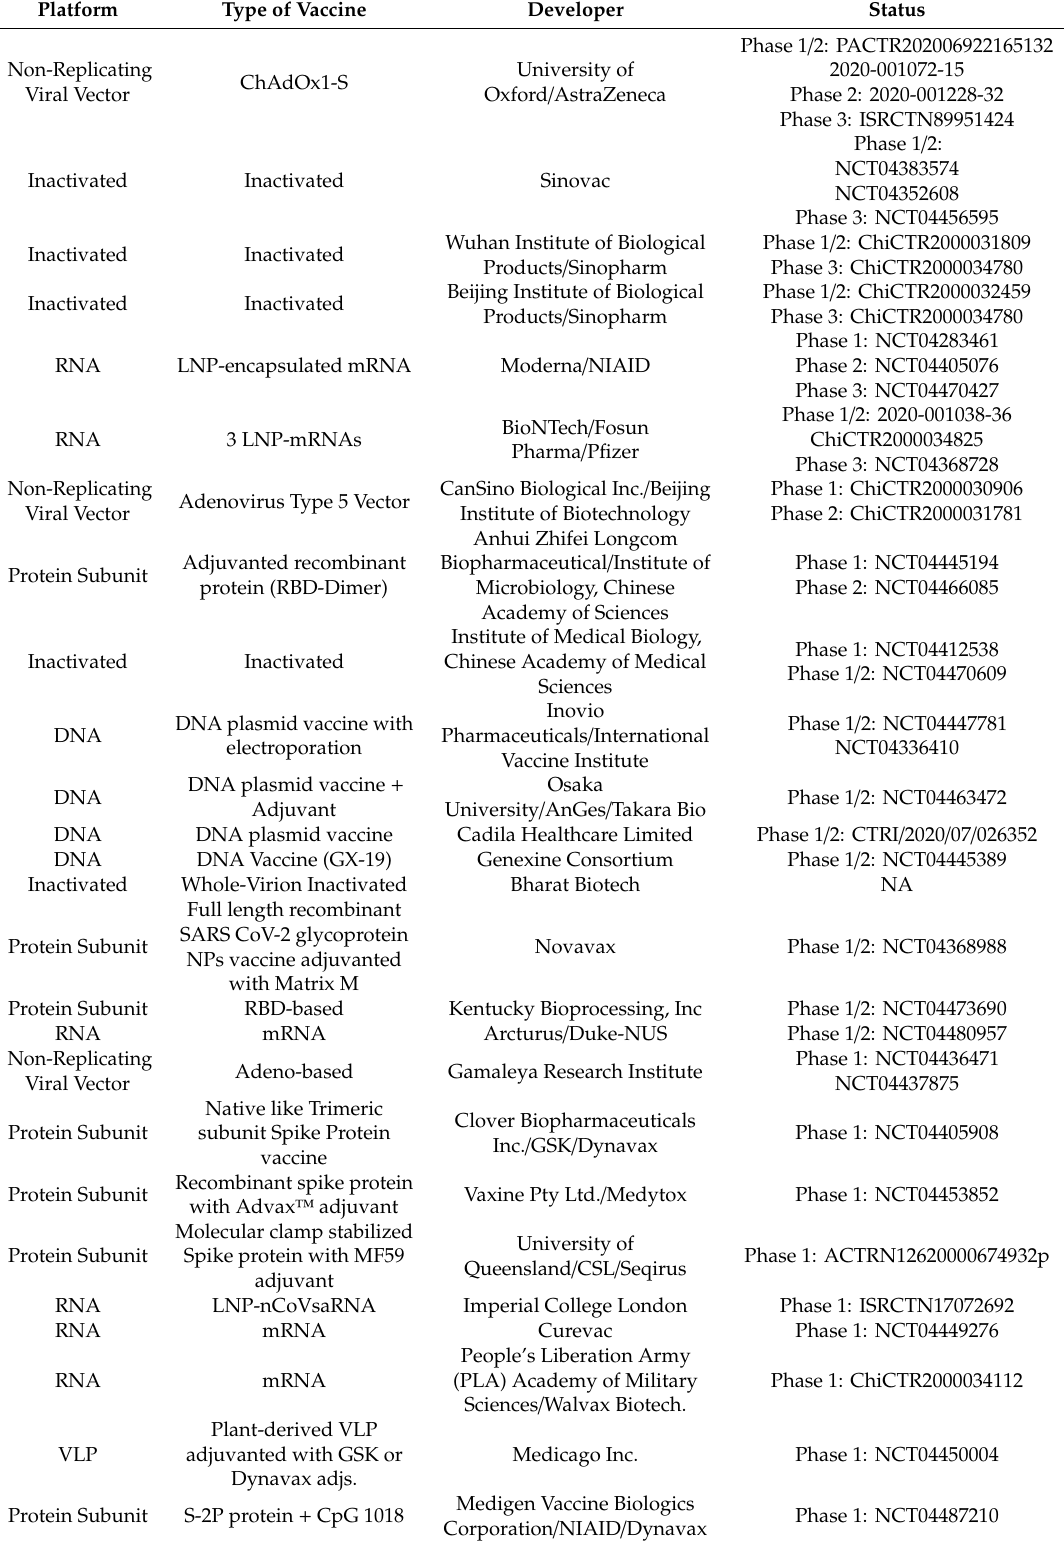
Table 2. List of candidate vaccines presently in clinical evaluation for COVID-19 (Source: WHO o ffi cial website, data accessed on 28 July